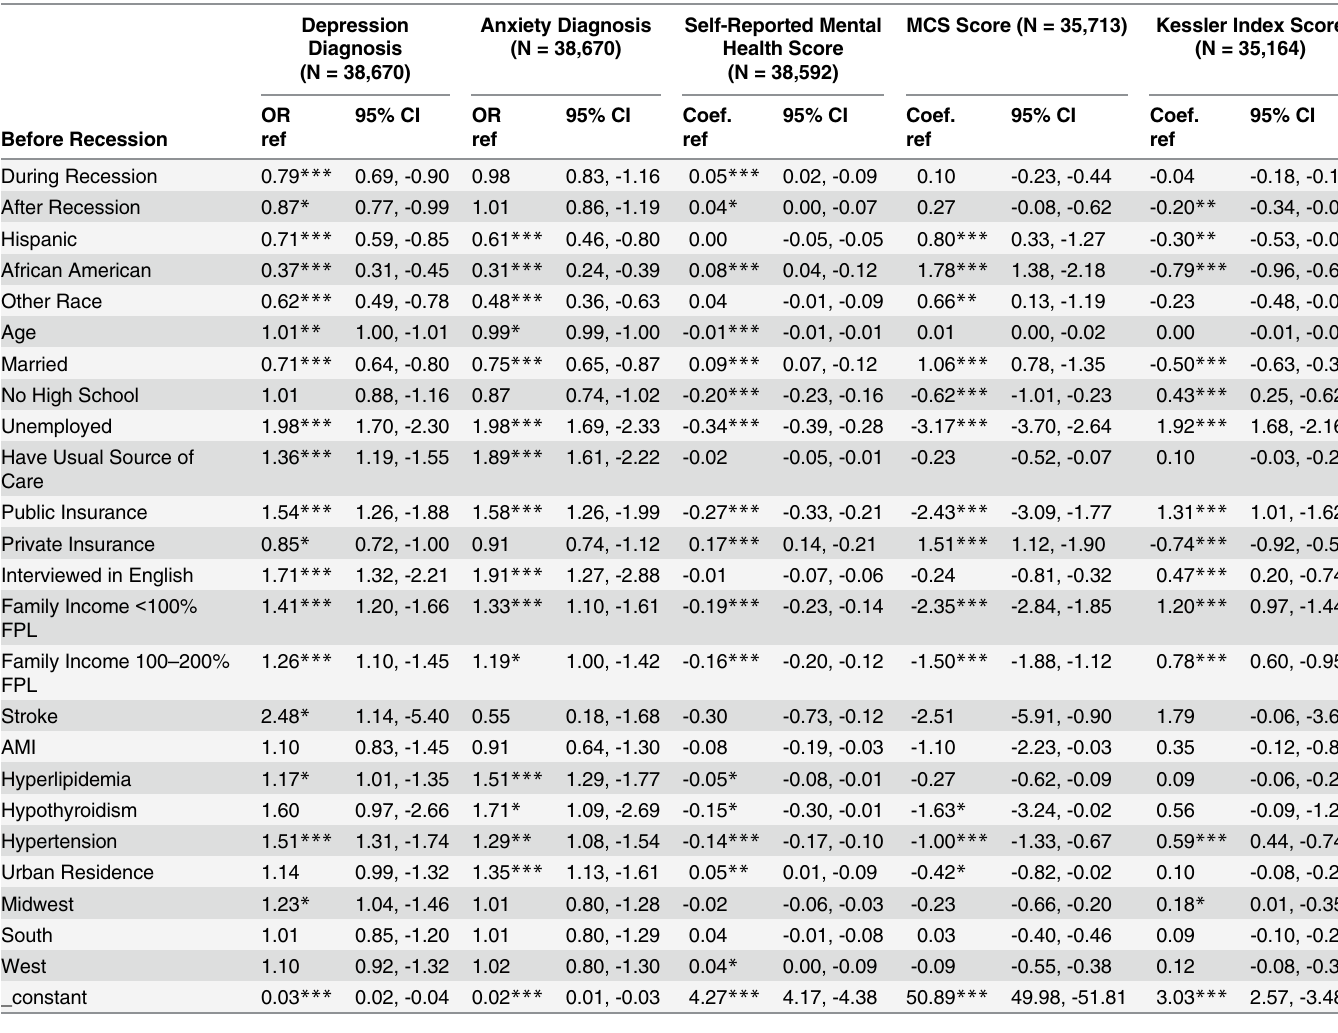
Table 5. Multivariate analyses of the associations between recession indicators (during and after) and mental health outcomes for males. Depression